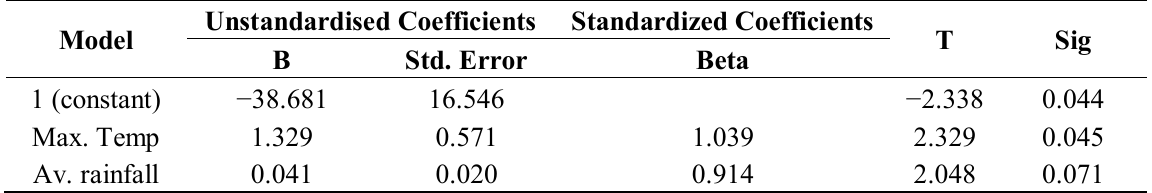
Table 3c. Regression coefficients a .